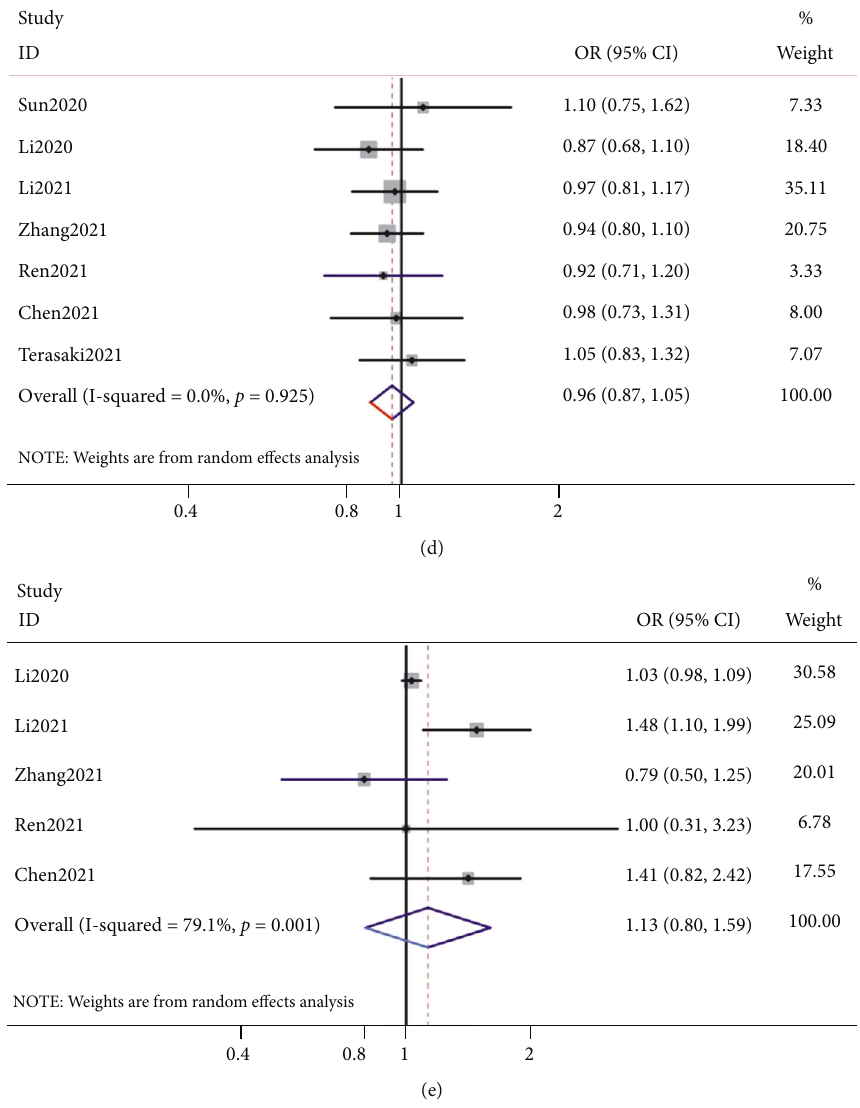
Figure 3: Forest plots of the correlation between the systemic immune-in fl ammation index and clinical features in biliary tract cancer. (a) Lymph node metastasis (yes vs. no); (b) vascular invasion (yes vs. no); (c) TNM stage (I – II vs. III-IV); (d) sex (male vs. female); (e) tumor di ff erentiation (poor vs.